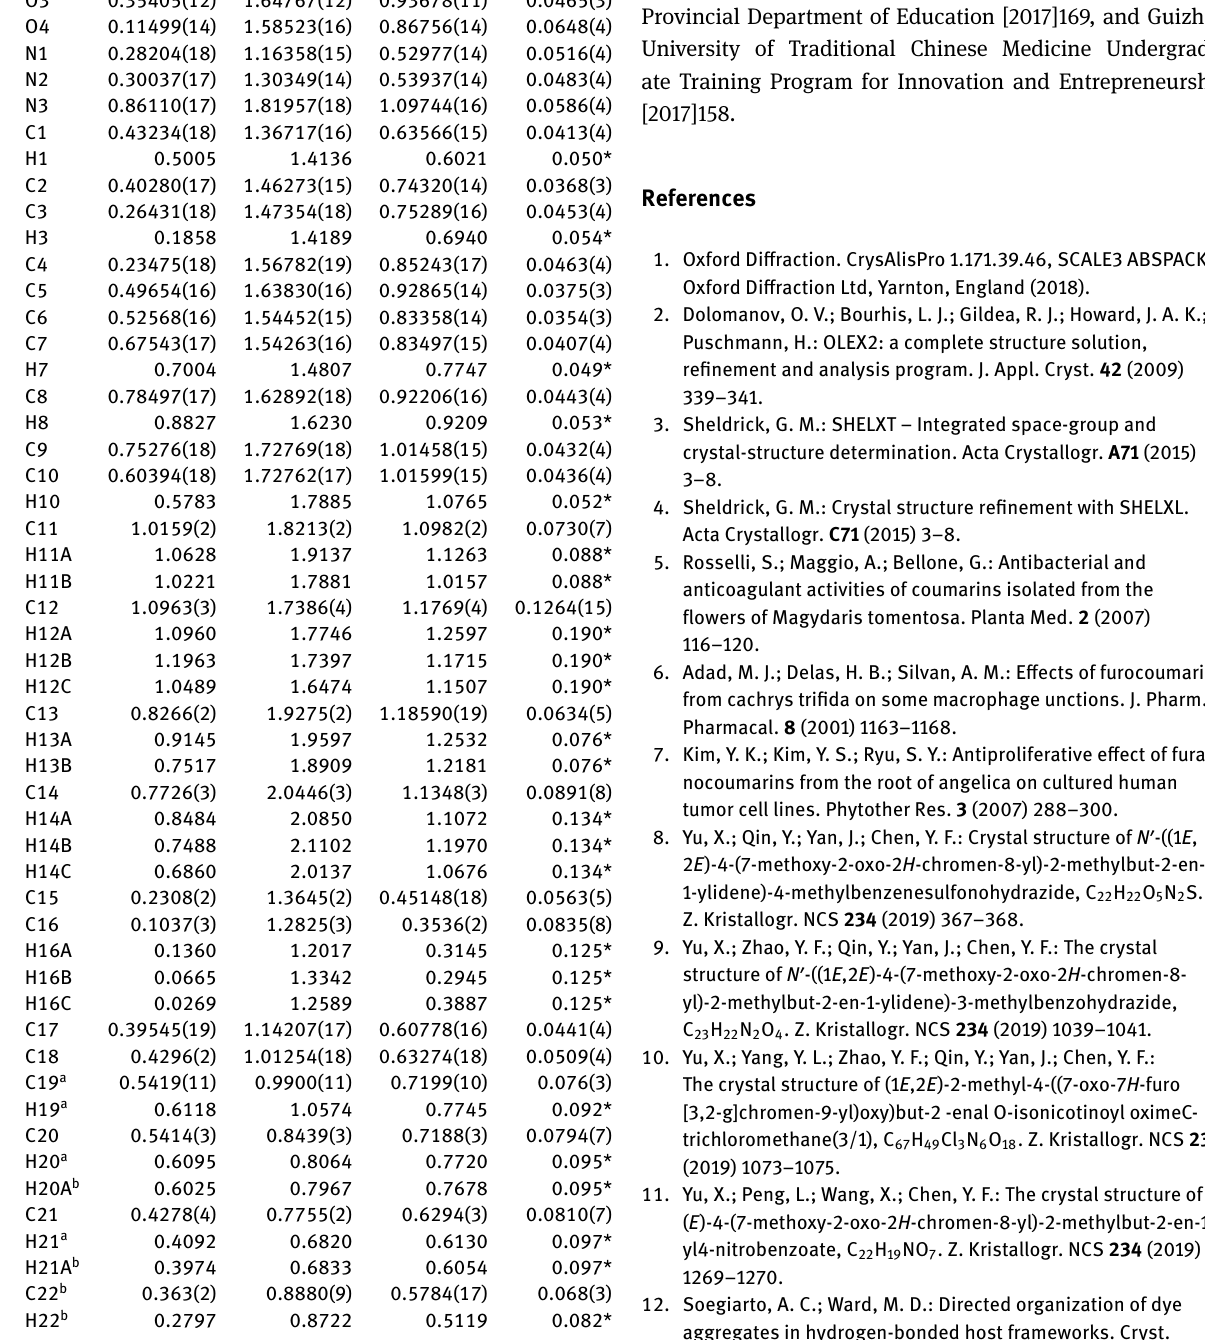
Table 2: Fractional atomic coordinates and isotropic or equivalent isotropic displacement parameters (Å 2 ).